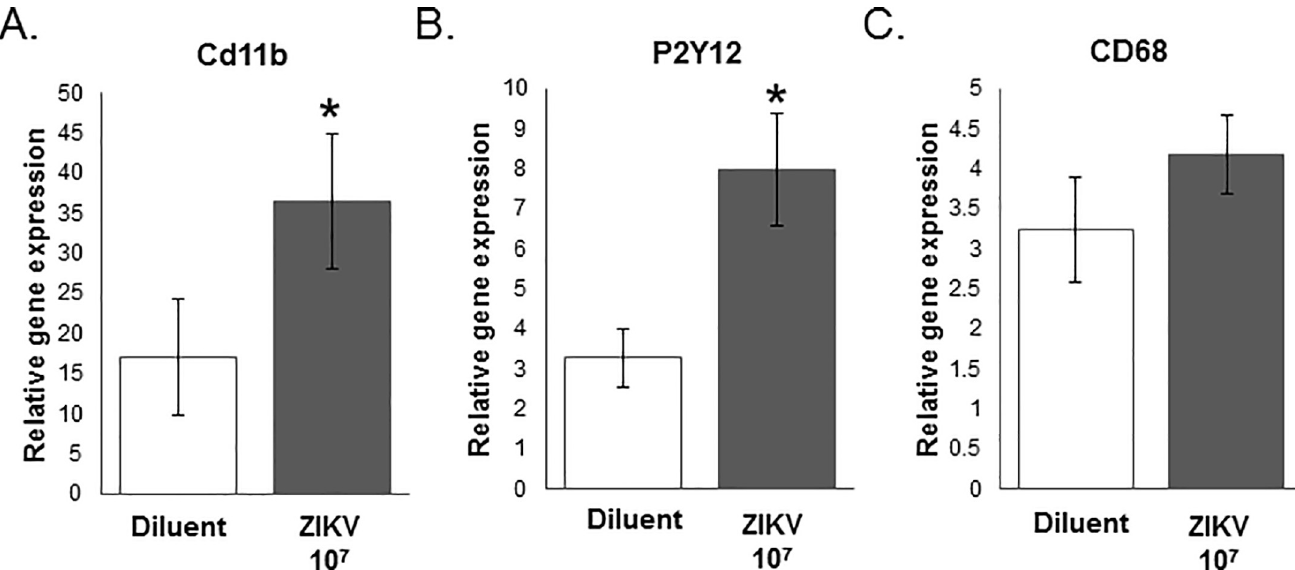
Fig 6. Gene expression analysis of microglial activation markers in the hippocampus/cortex of postnatal day 2 pups born of moms treated with ZIKV 10 7 or diluent control. (A) CD11b gene expression was significantly higher in the hippocampus/cortex of P2 pups exposed to ZIKV during gestation compared to controls (F1,16 = -1.83, P = 0.042; d = 0.817053). ( B ) P2Y12 gene expression is also significantly higher in the ZIKV group compared to controls (F1,16 = -2.73, P = 0.007; d = 1.346703). ( C ) CD68 gene expression did not significantly differ between the ZIKV and diluent control group (F1,16 = -1.17, P = 0.130; d = 0.548408). n = 8 (Diluent) n = 10 (ZIKV) animals per group. � : p < 0.05.